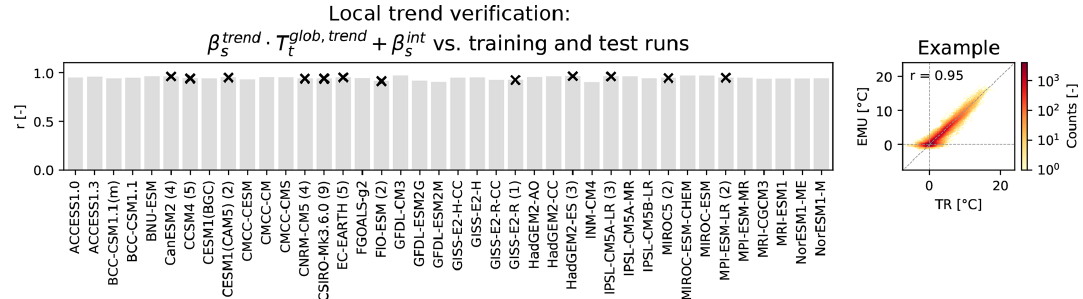
Figure 9. Local trend verification for the CMIP5 models by means of Pearson correlation between the emulated local trends and the training runs (gray bars). The example shows the associated 2-D histogram for CESM1(CAM5). For the CMIP5 models with test runs, the correlation between the emulated local trends and each individual test run is indicated by a black cross. Since these correlations are nearly identical for each test run of a specific climate model, the individual black crosses cannot be visually distinguished from one another. For all climate models with test runs, the number of available test runs is given in brackets after the model